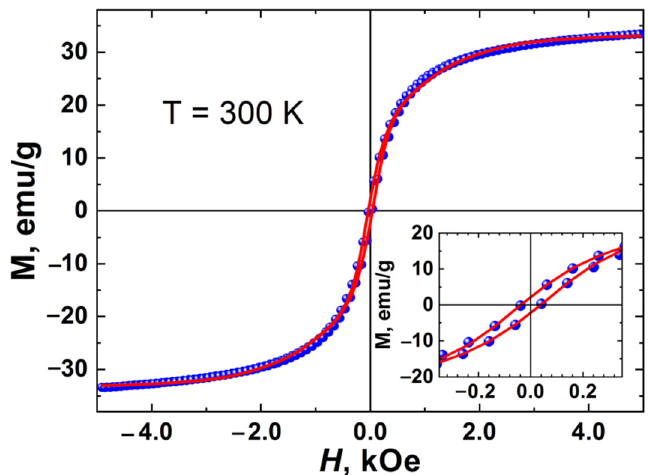
Figure 4. Experimental magnetization curve of a nanoparticles at room temperature (blue circles). The solid (red) lines show the curves calculated within the generalized Stoner–Wohlfarth model. The inset shows part of the curve at low magnetic fields.